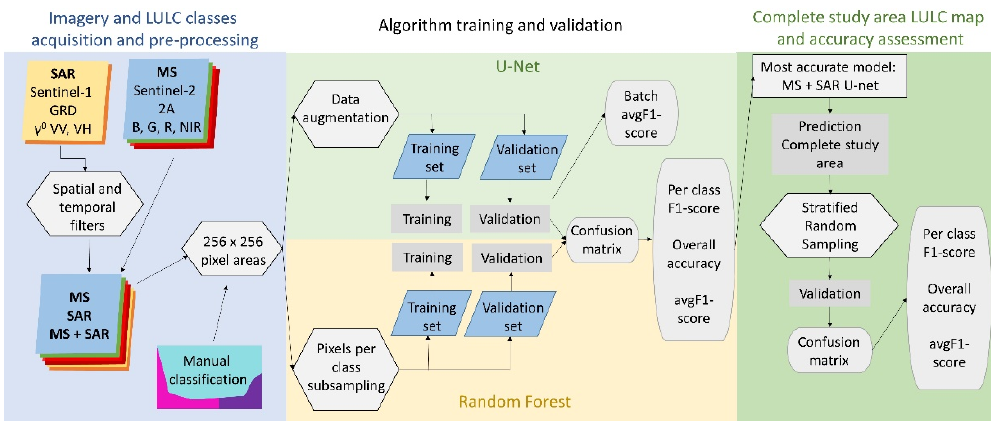
Figure 2. Schematic representation of the complete procedure used in the study.